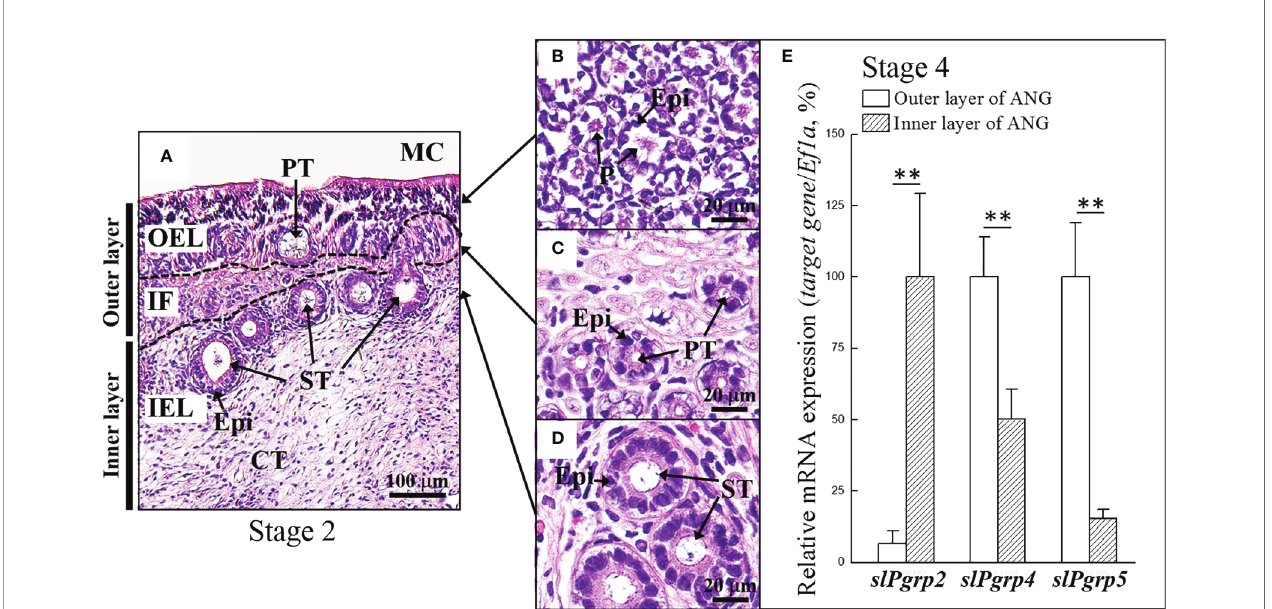
FIGURE 4 | Expression of slPgrp transcripts in different layers of ANG. (A) The de fi nition of outer and inner layer of ANG. (B, C) The outer layer of ANG was composed by outer epithelial cell layer and intermediate fi ber layer, respectively. (D) The inner layer of ANG was composed by inner epithelial cell layer. The relative portion of outer and inner layer of ANGs from mature female squid (stage 4, n = 4) were isolated under a stereomicroscope and analyzed separately. (E) Expression levels of slPgrp2 , slPgrp4 , and slPgrp5 were analyzed by qPCR. ** P < 0.01 comparing the outer and inner layer of ANGs. OEL, outer epithelial cell layer; IF, intermediate fi ber layer; IEL, inner epithelial cell layer; MC, mantle cavity; CT, connective tissue; Epi, epithelial cell; PT, primary tubule; ST, secondary tubule; P, pore.